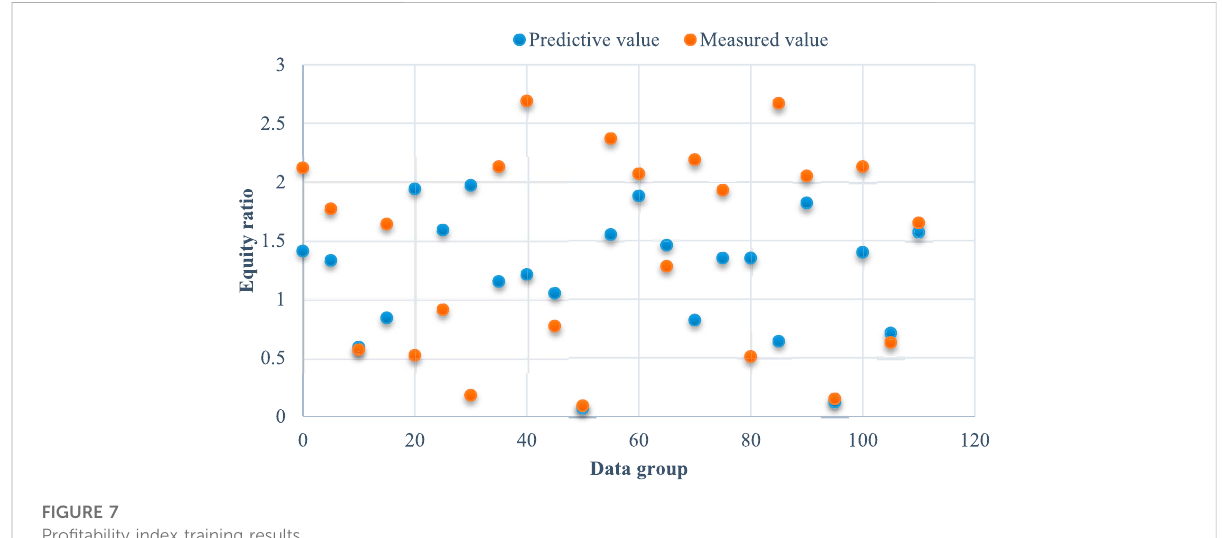
FIGURE 7 Pro fi tability index training results.